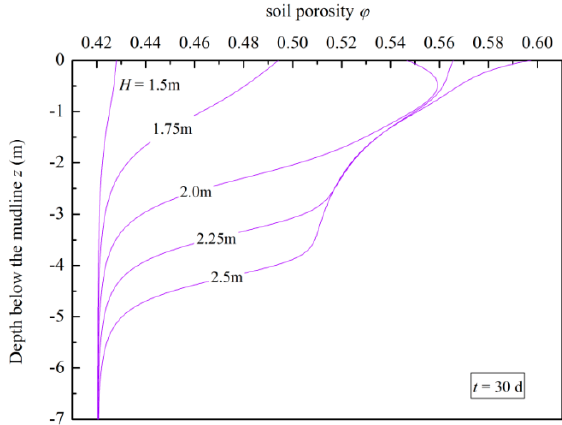
Figure 11. Variations of the soil porosity for different wave heights.